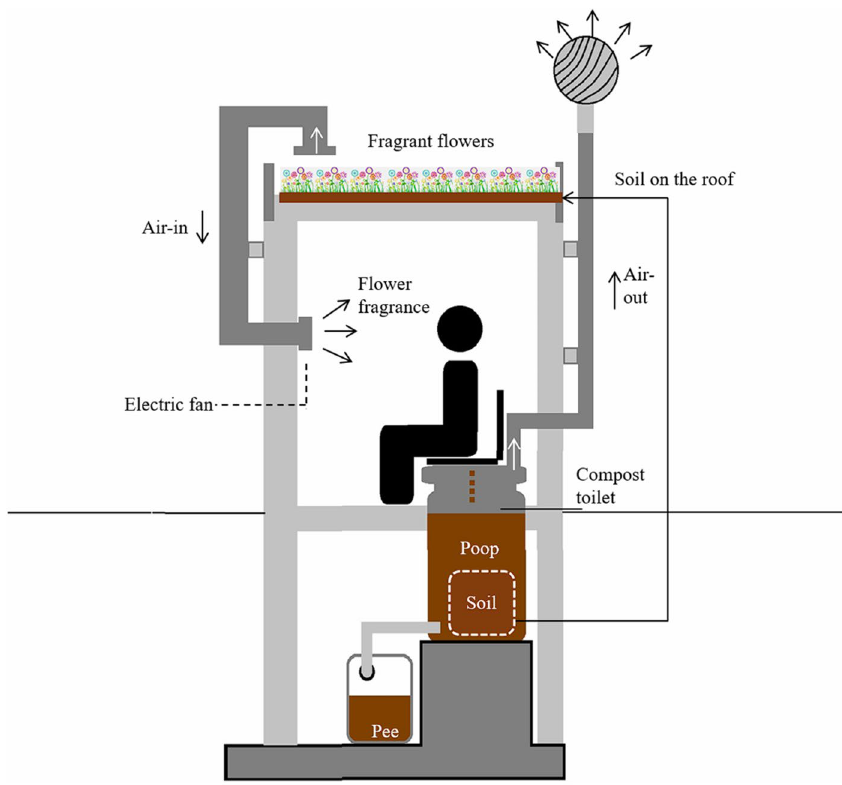
Fig. 11 A schematic diagram of a composting chamber located inside the toilet sealed to prevent unpleasant